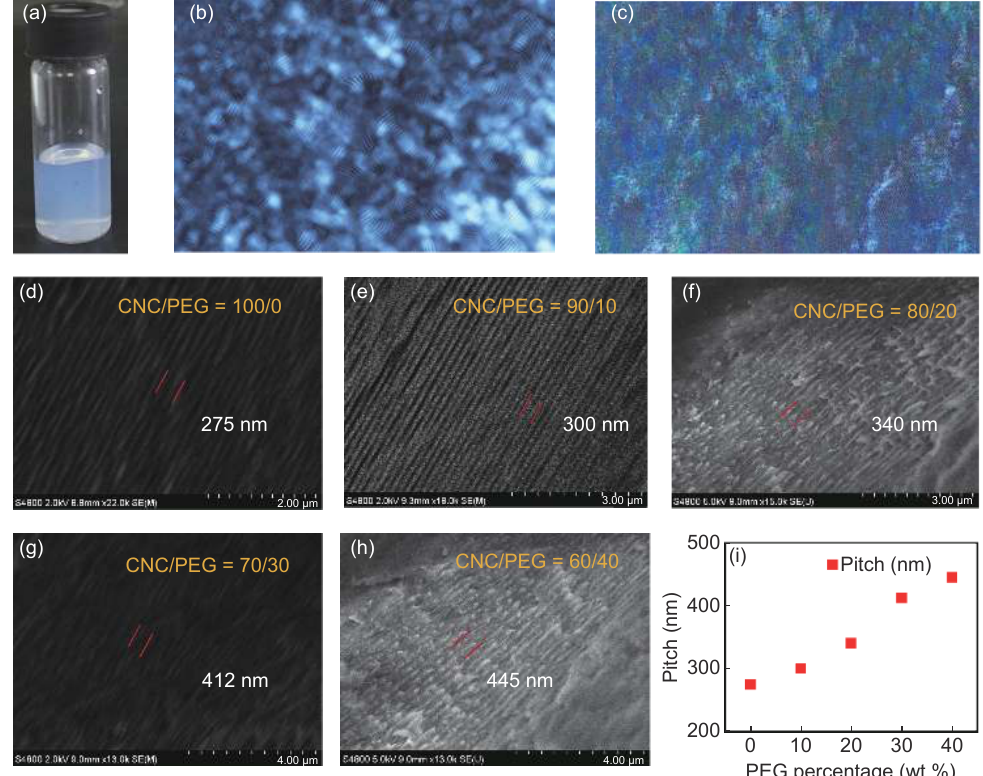
Figure 2 (a) Optical photograph and (b) polarized optical microscopy image of CNC/PEG/EuW 10 suspension with CNC/PEG = 80/20. (c) Polarized optical microscopy image of CNC/PEG/EuW 10 dry film. SEM images of CNC/PEG/EuW 10 composite films section: (d) CNC/PEG = 100/0; (e) CNC/PEG = 90/10; (f) CNC/PEG = 80/20; (g) CNC/PEG = 70/30; (h) CNC/PEG = 60/40; (i) the helical pitch as a function of the PEG content for CNC/PEG/EuW 10 composite